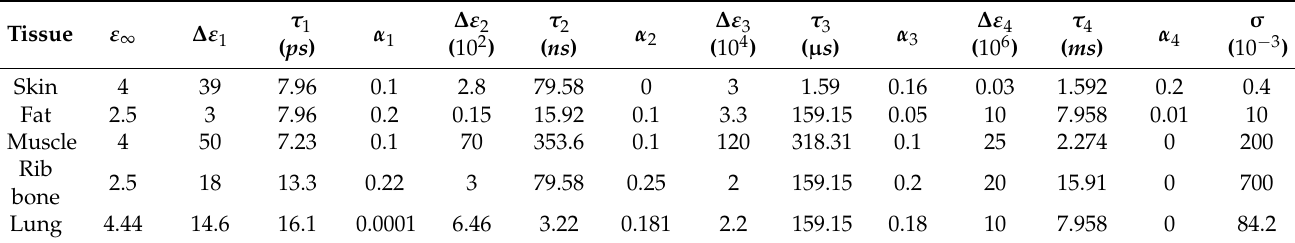
Table 1. Parameter values for each tissue of the human torso.